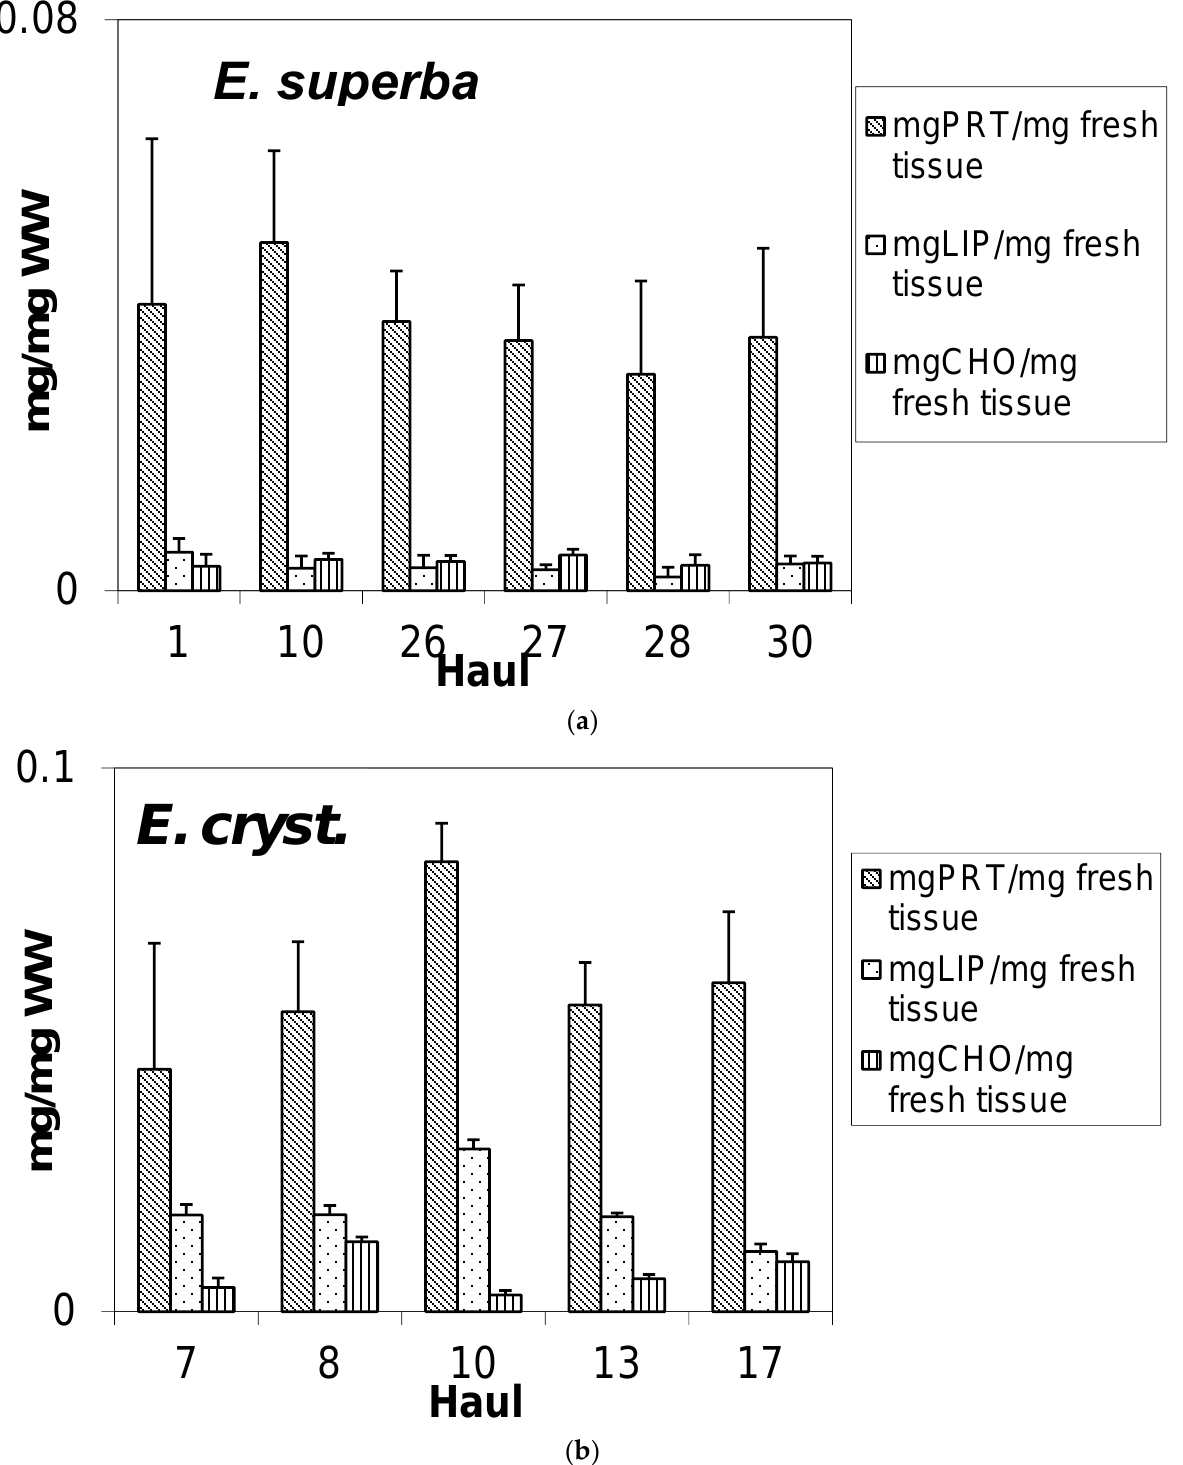
Figure 3 . ( a ) Mean content in lipids, proteins, and carbohydrates (mg/mg wet weight) with standard deviation intervals in the selected hauls for E. superba ; ( b ) Mean content in lipids, proteins, and carbohydrates (mg/mg wet weight) with standard deviation intervals in the selected hauls for E. crystallorophias . CHO = carbohydrates, LIP = lipids, PRT = proteins, WW = wet weight. The biochemical composition (in mg/mg of fresh tissue) and size of specimens of both krill species collected at haul n. 10 were analysed using one-way ANOVA and Newman – Keuls test, which highlighted significant differences in lipids, carbohydrate content, and TL, whereas differences in protein content were not significant (Table S1), showing evi- dence that the main differences between the two species in terms of biochemical compo- sition are due to lipid and carbohydrate contents and not due to protein contents.